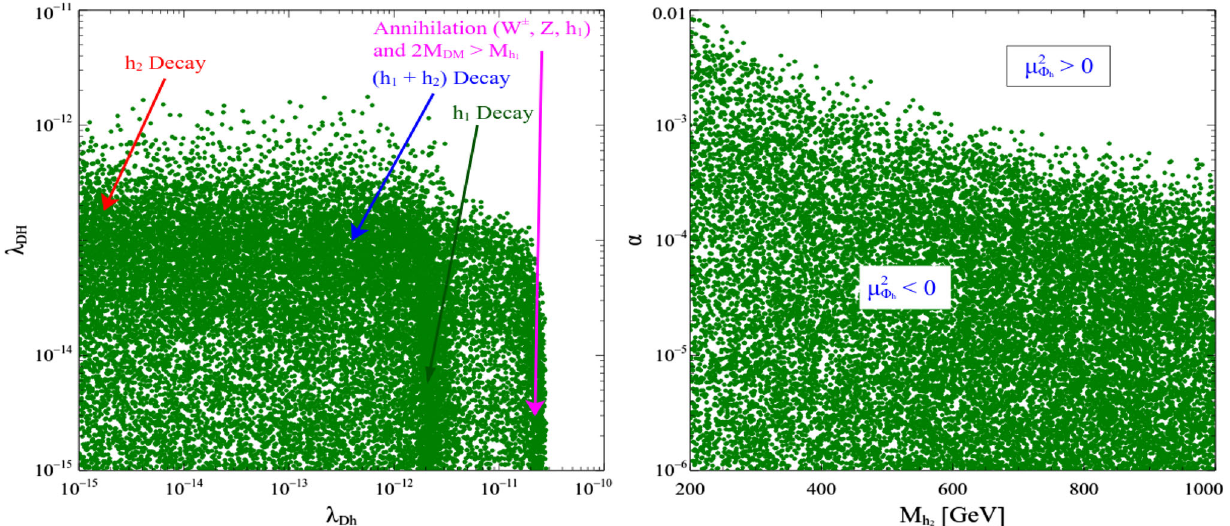
= 3000 GeV, g = 0 . 07, BL BL